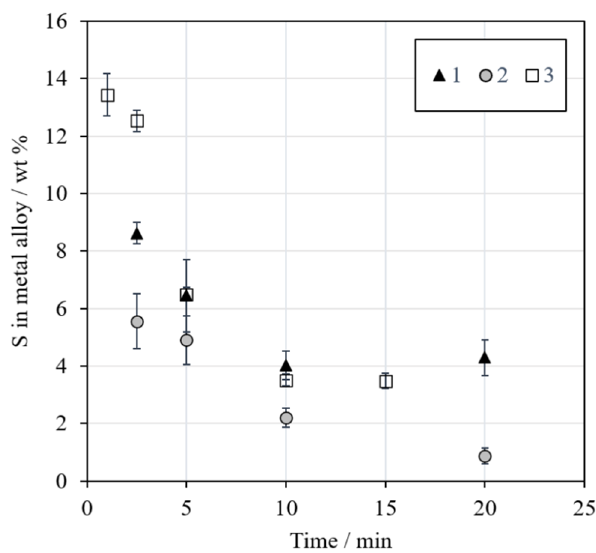
Figure 11. Concentration (wt %) of sulfur in the metal alloy as a function of reduction time.